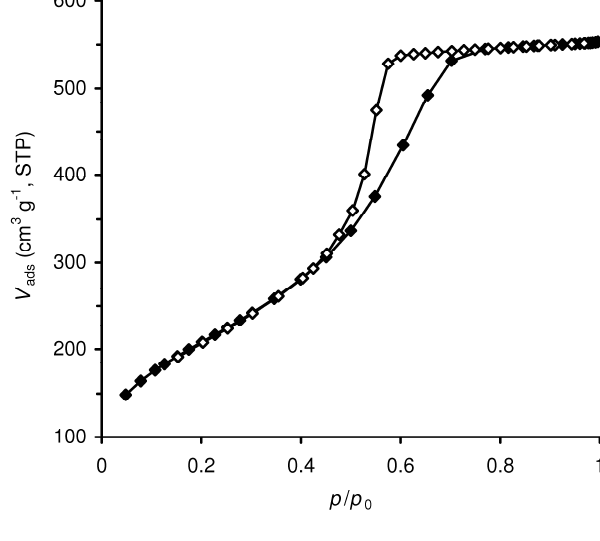
adsorption-desorption isotherms at -196 ºC of Figure 2. N 2